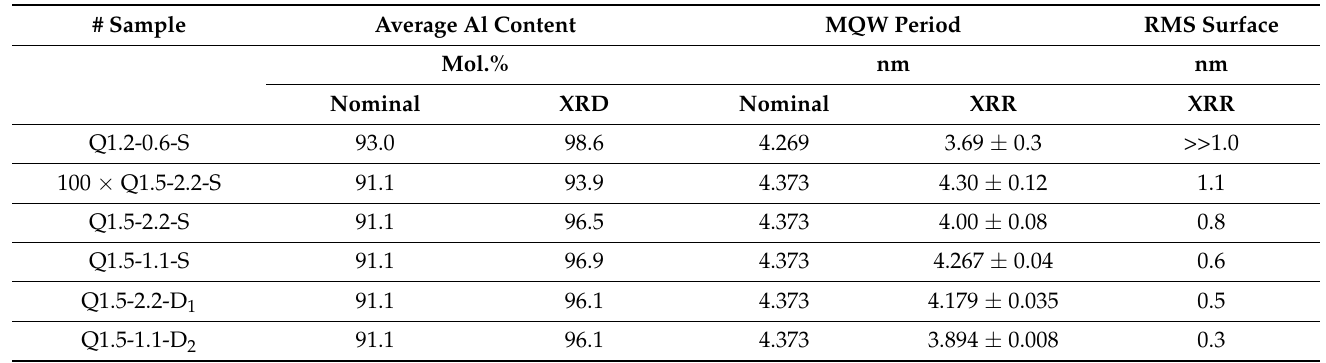
Table 2. Parameters of MQW structures found from the simulations of data measured by XRD θ /2 θ scans and longitudinal scans of